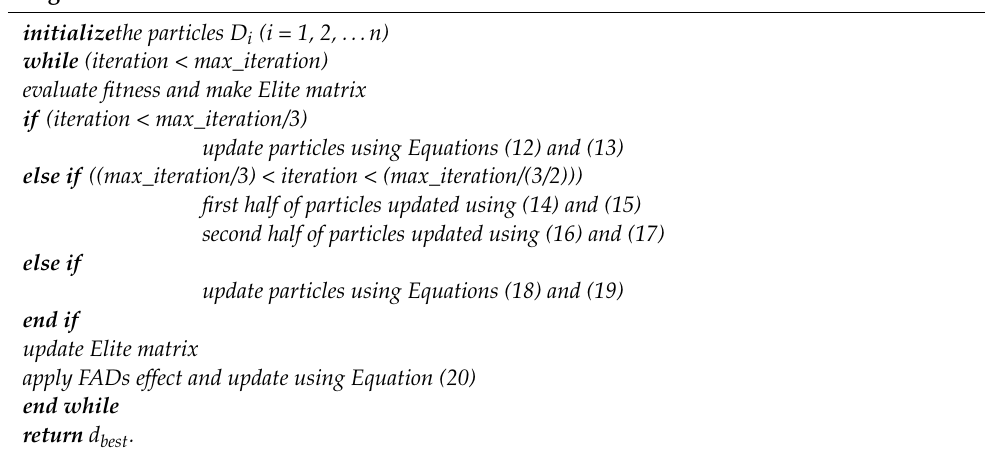
Algorithm1: MPA-based MPPT Pseudo-code